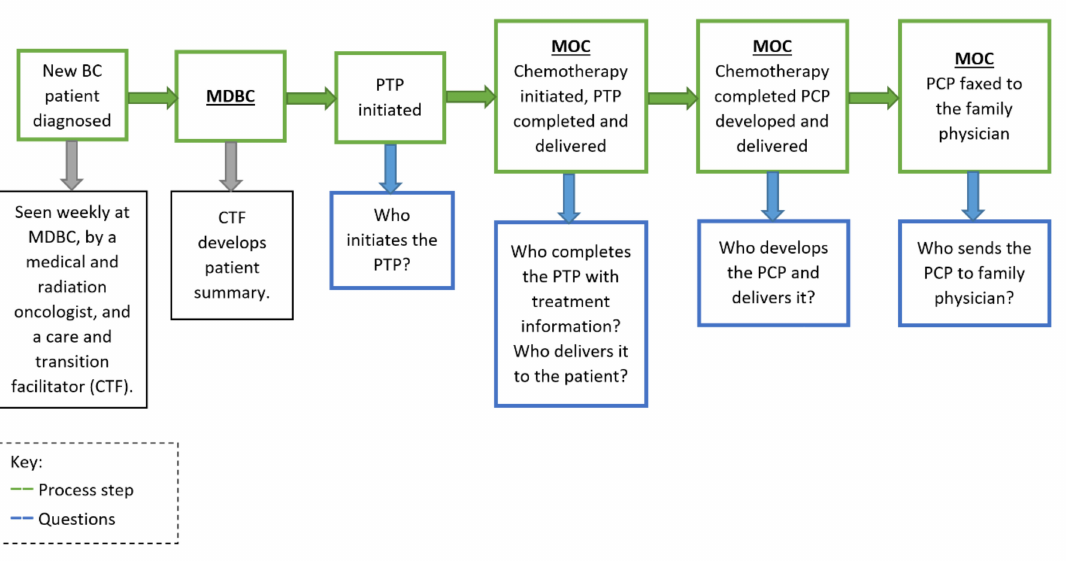
Figure 1. Personalized treatment plan and care plan implementation process. BC = newly diagnosed breast cancer patient, MDBC = multidisciplinary breast clinic, MOC = medical oncology clinic, BC = breast cancer, CTF = care transition facilitator, PTP = personalized treatment plan, PCP = personalized care plan, PCP = primary care